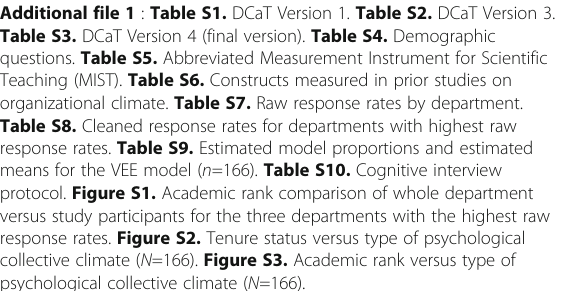
protocol. Figure S1. Academic rank comparison of whole department versus study participants for the three departments with the highest raw response rates. Figure S2. Tenure status versus type of psychological collective climate ( N =166). Figure S3. Academic rank versus type of psychological collective climate ( N